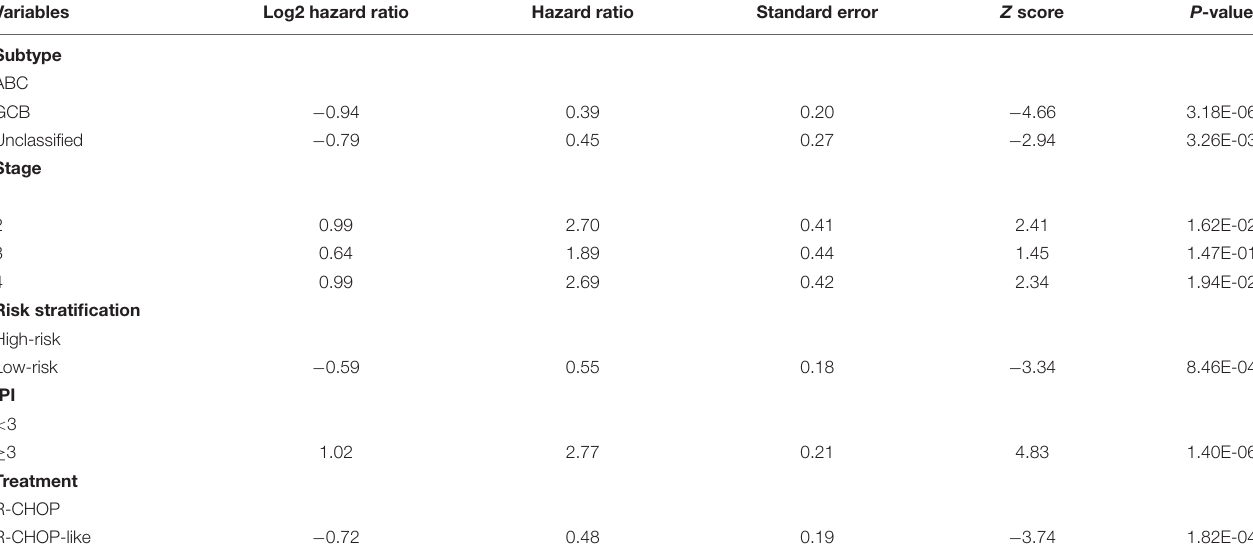
TABLE 2 | The statistics for the risk stratification and prognostically clinical factors in the multivariable Cox model. Variables Log2 hazard ratio Hazard ratio Standard